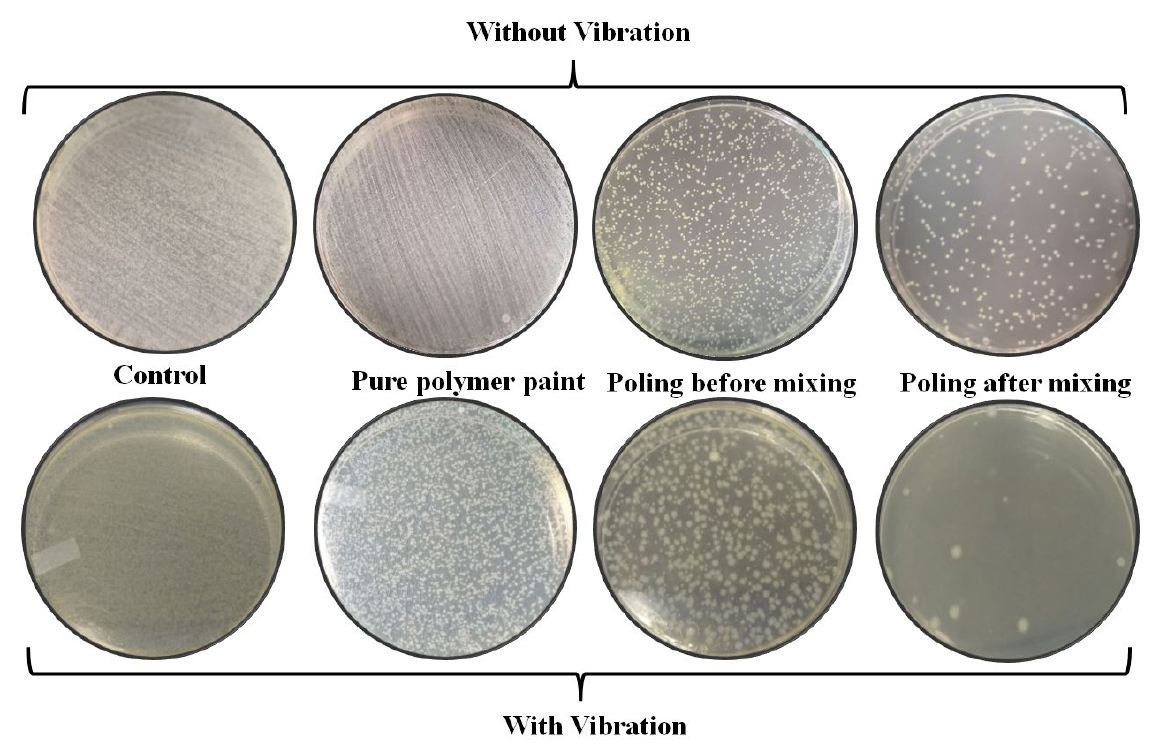
Figure 7. Real-time images of E. coli bacteria cell colonies after 180 min.